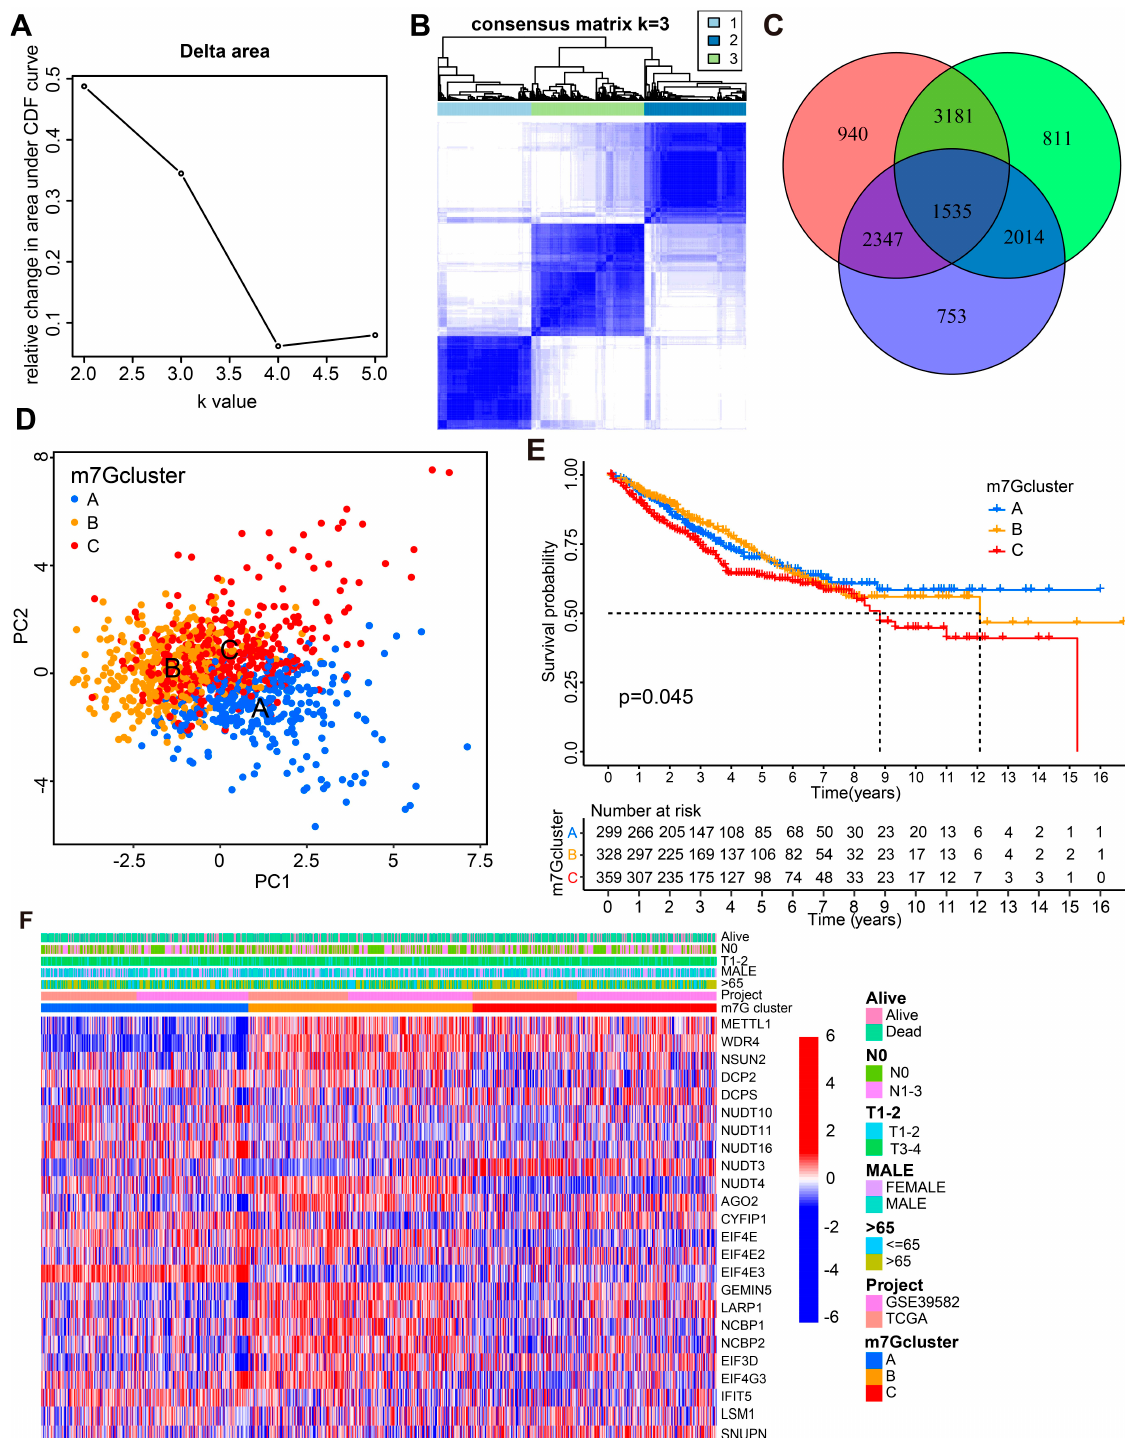
Figure 2. The construction of m7G-related subtype clusters. ( A ) Cumulative distribution function curve illustrates the most effective way of m7G clustering. ( B ) The consensus matrix of the clustering analysis based on m7G expression profiles via k-means clustering (k = 3). ( C ) The Venn diagram depicted the intersection of differentially expressed genes among different m7G clusters. ( D ) The principal component analysis (PCA) for m7G clusters. ( E ) Kaplan–Meier (KM) curves for the overall survival (OS) of CC patients among different m7G groups. ( F ) Heatmap of m7G-associated genes’ expression in CC patients with different clinical characteristics, data sources and m7G clusters.